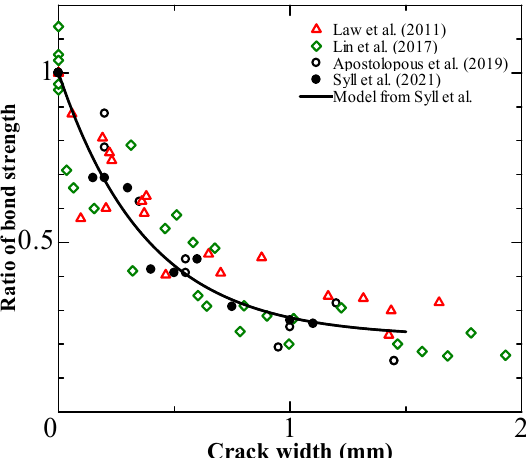
Figure 23. Comparison of Syll et al. [100] formulas with experimental results from the literature [73,74,76].